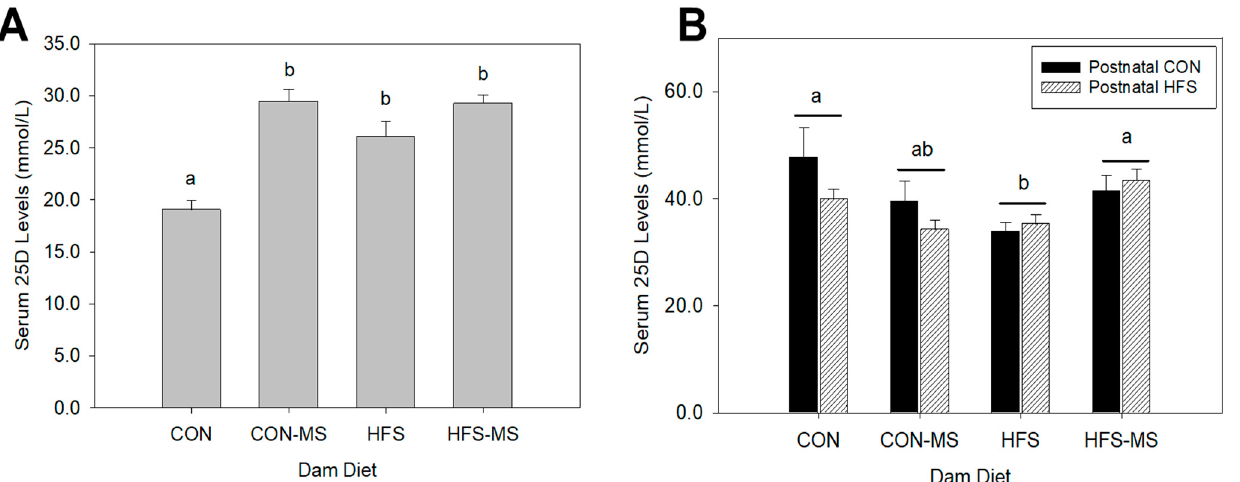
Figure 1. Circulating 25-hydroxycholecalciferol (25D) in weanling ( A ) and adult ( B ) offspring born to dams fed a control (CON) or high-fat, high sucrose (HFS) diet with or without methyl-donor nutrient supplementation (MS). Data are pooled from both sexes. Different letters indicate significant differences between maternal diets at p < 0.05. Data are expressed as mean ± SEM ( n = 10/group). Postnatal CON, control postnatal diet; postnatal HFS, high-fat, high-sucrose postnatal